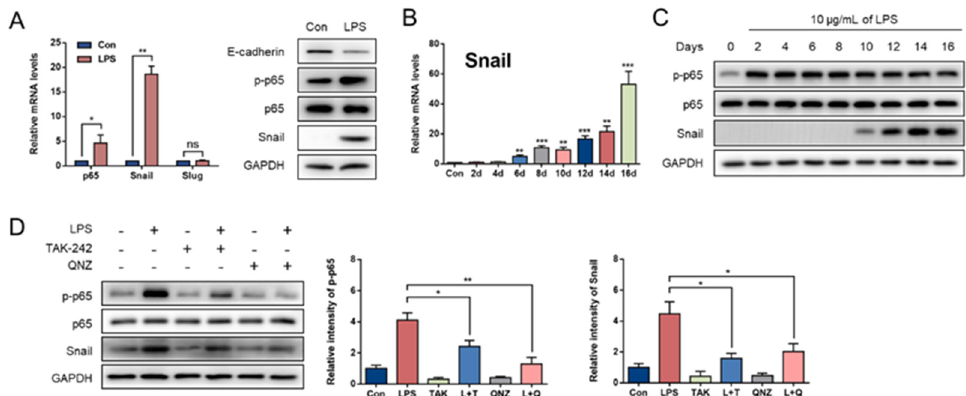
Figure 2. LPS activated NF- κ B/Snail signaling pathway in GMECs. ( A ) mRNA expression of p65 and Snail after LPS treatment for 14 d. (original western blot figures in Figure S2). ( B ) mRNA expression of Snail during LPS treatment for 16 d. * Indicates a significant difference compared with the control group. * p < 0.05, ** p < 0.01, *** p < 0.001. ( C ) Protein expression of p65 and Snail during LPS treatment for 16 d. (original western blot figures in Figure S3). ( D ) The effects on p65/Snail expression by inhibiting the TLR4/NF- κ B signaling pathway with TAK-242 (TAK/T, TLR4 inhibitor) or QNZ (Q, NF- κ B inhibitor), L + T = LPS + TAK-242, L + Q = LPS + QNZ. (original western blot figures in Figure S4). * Indicates a significant difference between two groups, * p < 0.05, ** p <0.01, *** p < 0.001, ns = no significance.